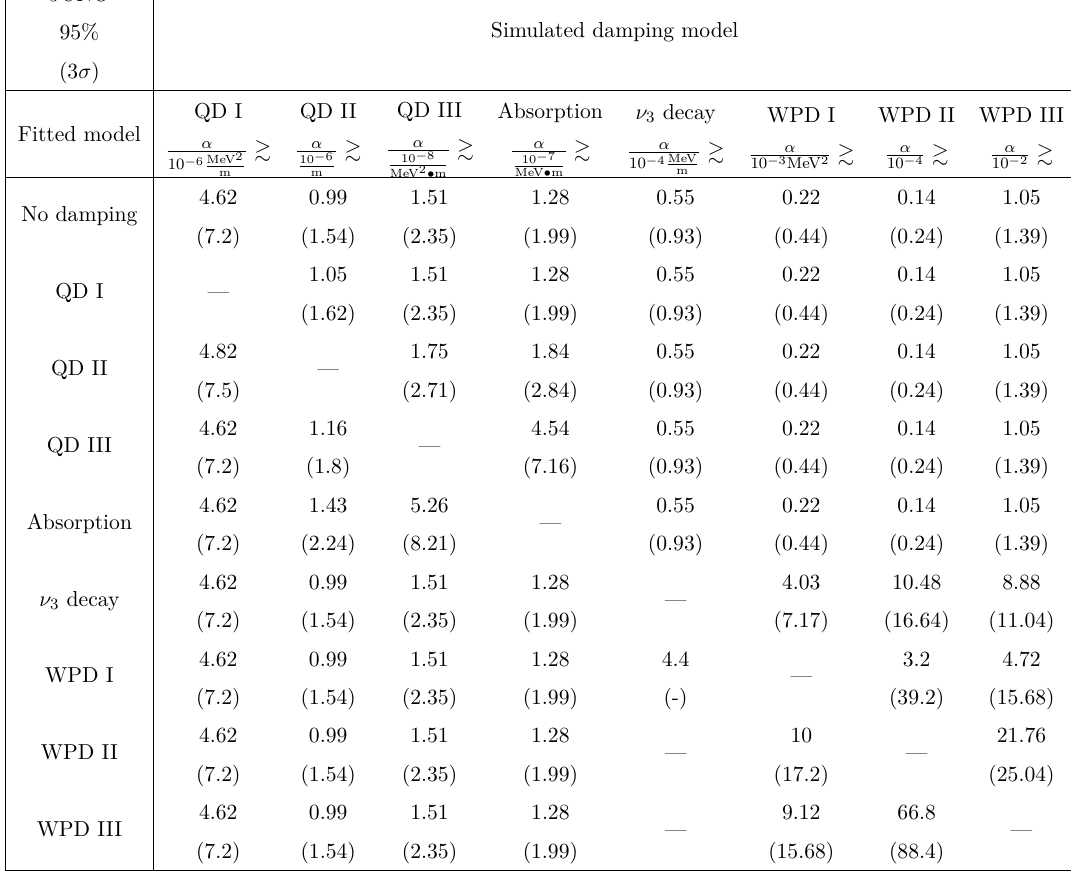
Table 4. The sensitivity limits on α for which a certain simulated damping model (in columns) could be distinguished from a certain fitted model (in rows) at